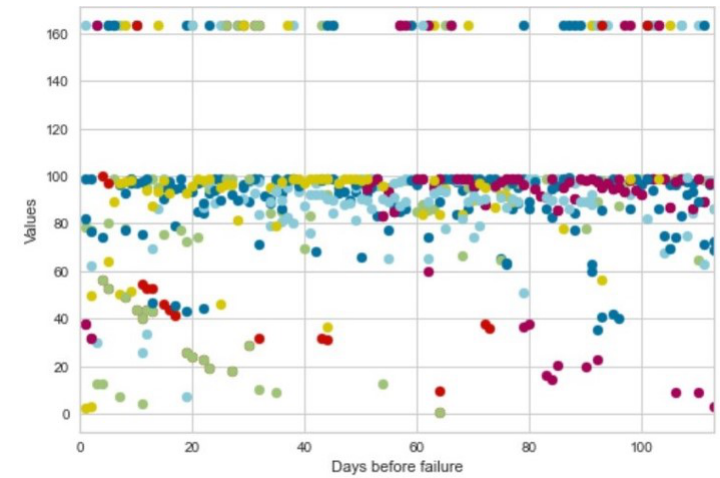
Figure 10. Behavior in time for cases.